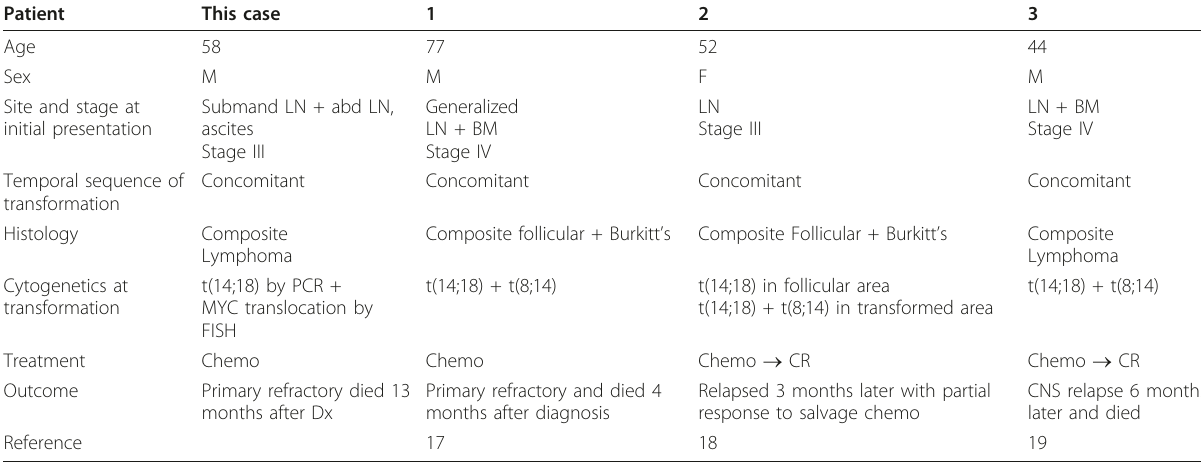
Table 1 Patients with composite histology of atypical Burkitt ’ s and follicular